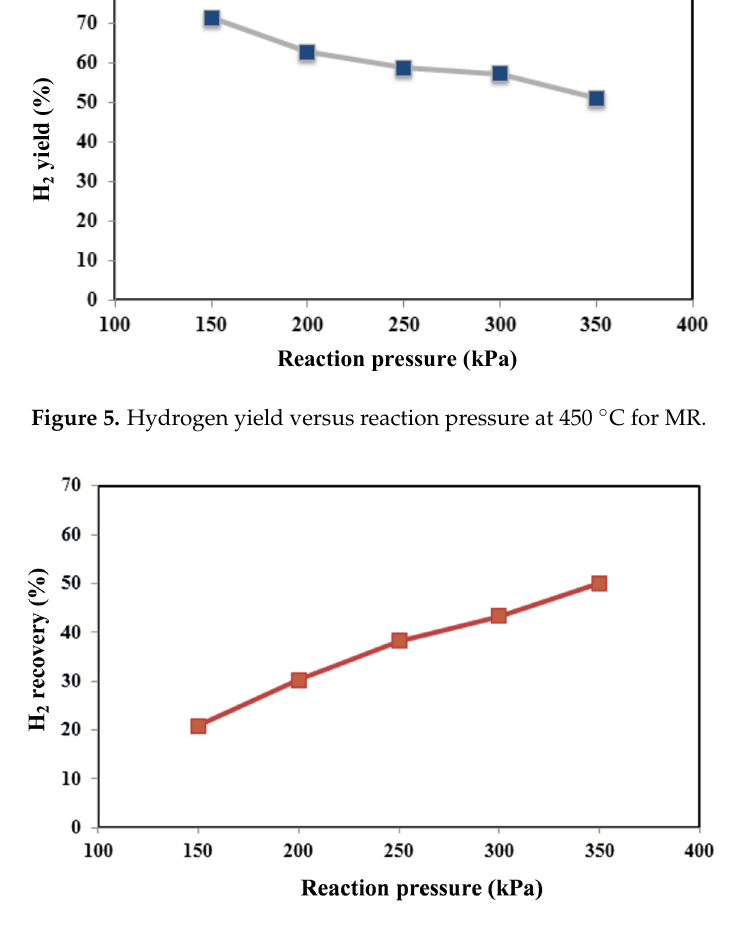
Figure 6. Hydrogen recovery versus reaction pressure at 450 °C for MR.